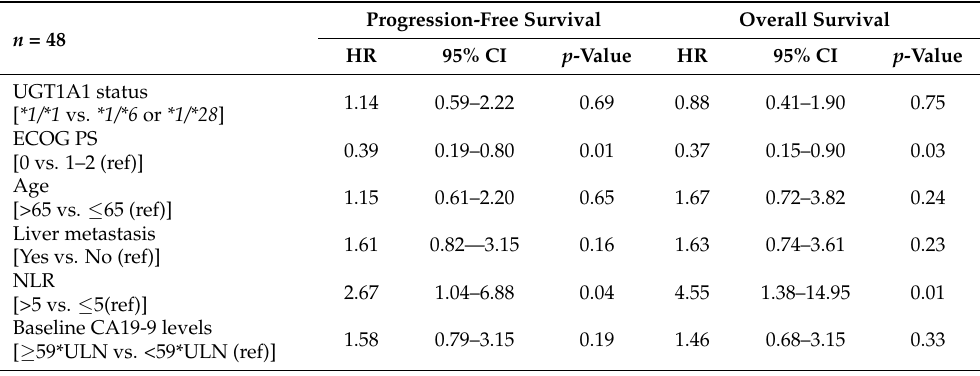
Table 6. Multivariate analysis for PFS and OS in UGT1A1 analysis set ( n = 48). Progression-Free n = 48